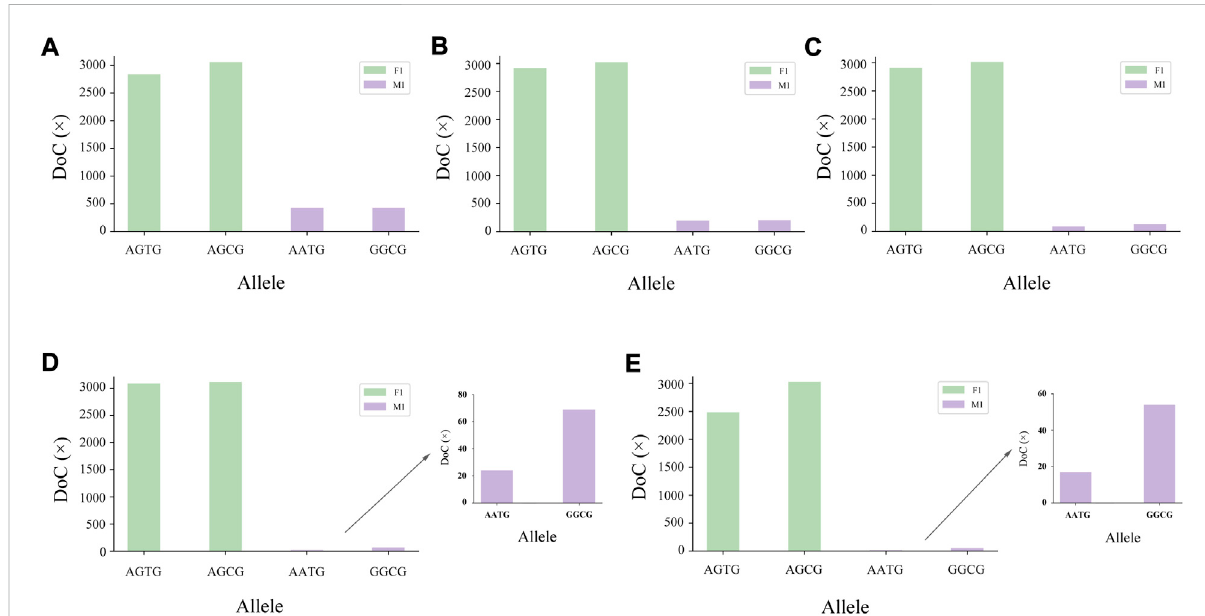
FIGURE 3 Schematicdiagramoftwo-personmixtureatMH13KK217locus.TheallelesofF1wereAGTG/AGCG,theallelesofM1wereAATG/GGCG. (A) Mix ratio = 9:1, (B) Mix ratio = 19:1, (C) Mix ratio = 49:1, (D) Mix ratio = 99:1, and (E) Mix ratio =